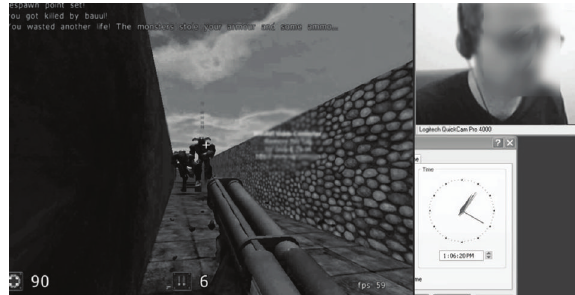
Figure 1: Game and face video playback, used for self-assessment of arousal.